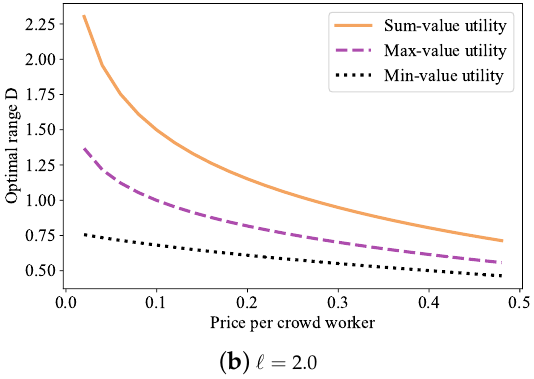
Figure 6. The optimal recruiting range with different parameter (cid:96) .